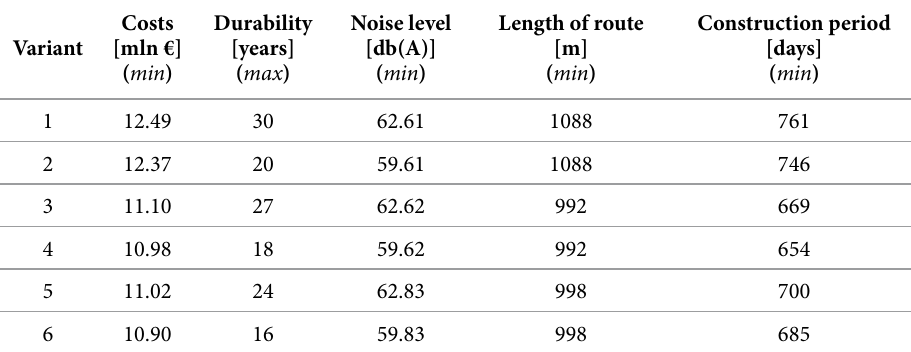
Table 1. Multiple-criteria analysis in the construction of motorways